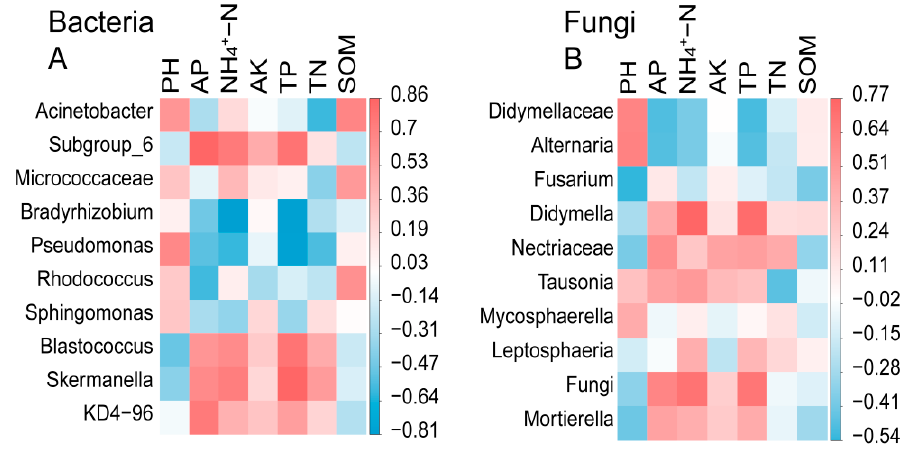
Figure 8. Correlation between genus level of variance and soil properties of differential bacterial ( A ) and fungal ( B ).